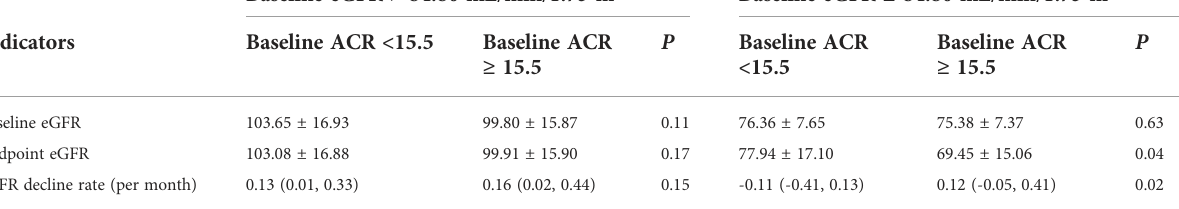
TABLE 9 The subgroup analysis of eGFR and eGFR decline rate in the normal and high-normal group of UACR according to the cut-off value of